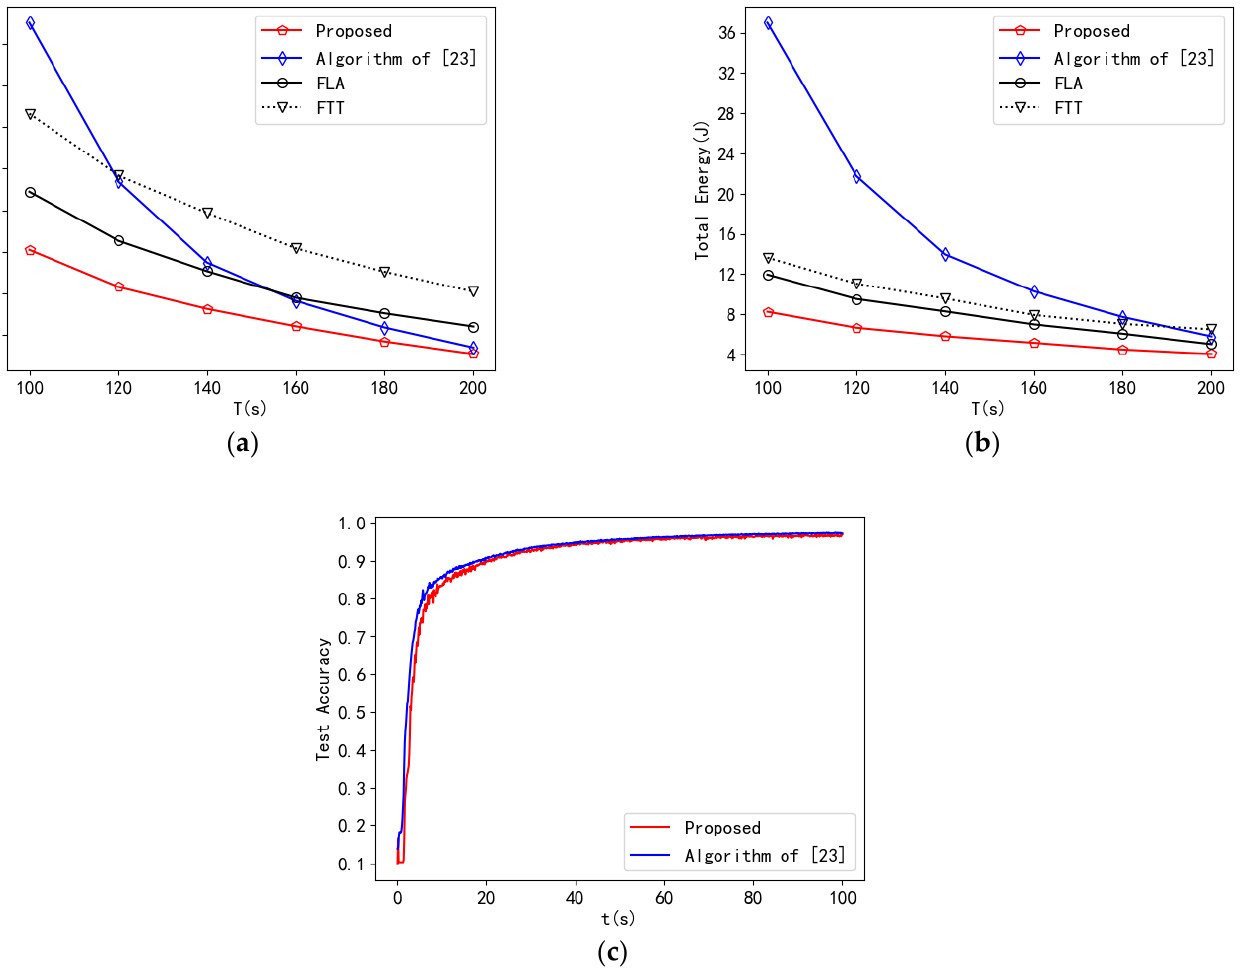
Figure 3. Total Completion Time Influence on Performance: ( a ) total system cost; ( b ) total energy consumption of users; ( c ) learning performance